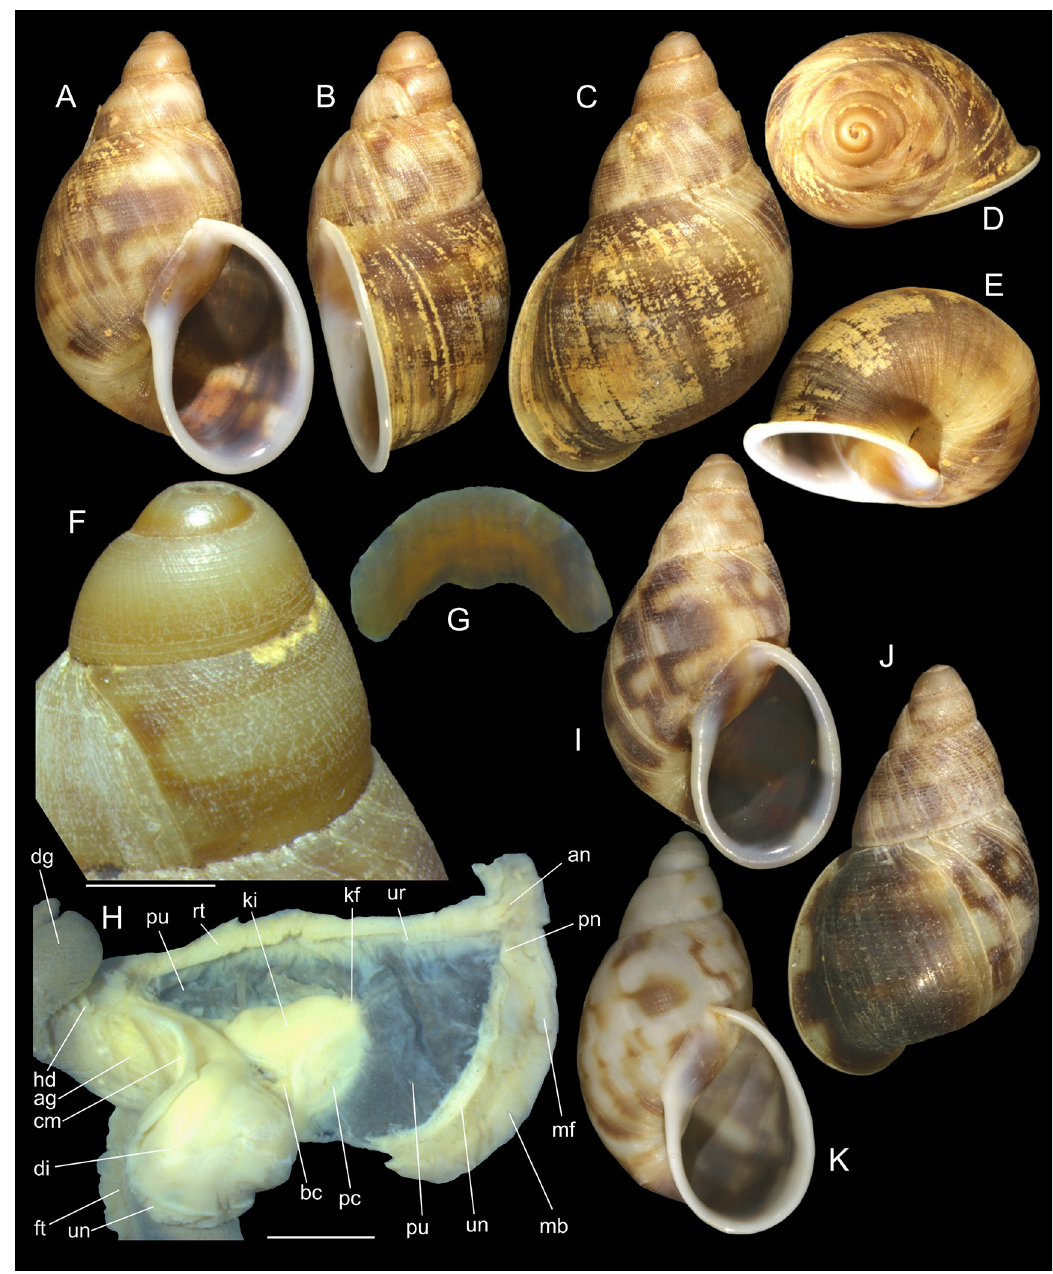
Fig 16. Anthinus savanicus , shell of types and anatomical details. (A-H) holotype MZSP 154391 (L 32.5 mm). (A) shell, frontal view. (B) right view. (C) dorsal view. (D), apical view. (E) inferior (umbilical) view. (F) protoconch and part of first teleoconch, profile, scale = 2 mm. (G) jaw, ventral view (L 1.7 mm). (H) almost entire specimen, mostly dorsal view, pallial cavity removed and deflected right (ventral view), head-foot deflected below, visceral mass slightly uncoiled, scale = 5 mm. (I-J) paratype MZSP 153897 (L 31.5 mm), frontal and dorsal views. (K) paratype MZSP 152171 (L 35.3 mm), frontal view. Type locality. BRAZIL. Goia ´ s ; north of Formosa, 15˚21’50”S 47˚27’08”W [Weslley Vailant de Matos col, ix.2012].